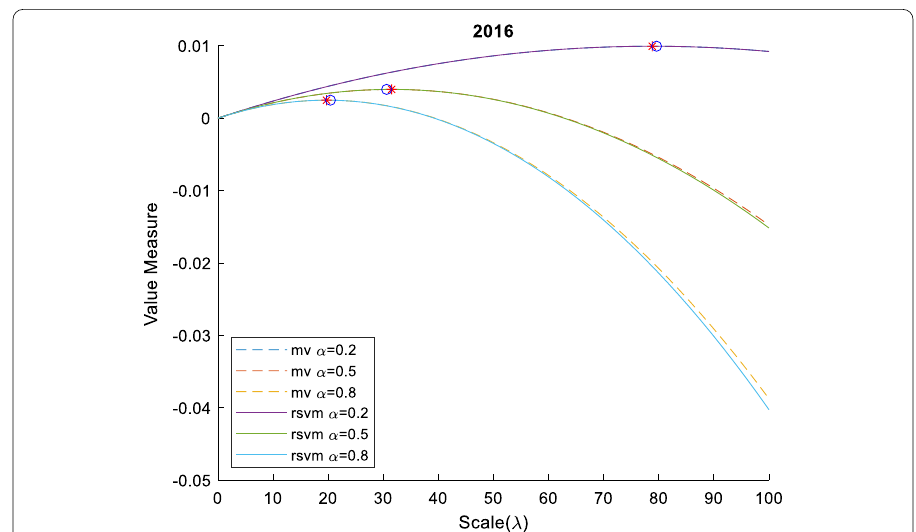
Fig. 3 Value measure of RSVM and MV with various risk aversion α and scale (cid:31) in 2016. This figure shows the relation between value measure (mean–variance model with dash line and risk‑sensitive value measure with line) and scale with different investors (risk‑averter α = 0.8 , risk‑neutral α = 0.5 , and risk‑seeker α = 0.2 ) in 2016. The red star and blue circle are optimal scale of mean–variance model and risk‑sensitive value measure, respectively